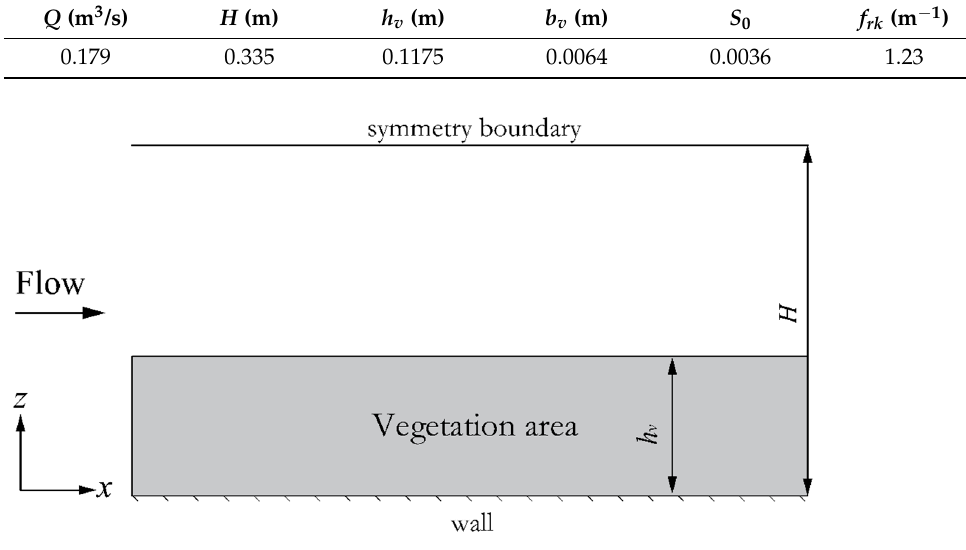
Figure 2. Schematic diagram of longitudinal section of simulation